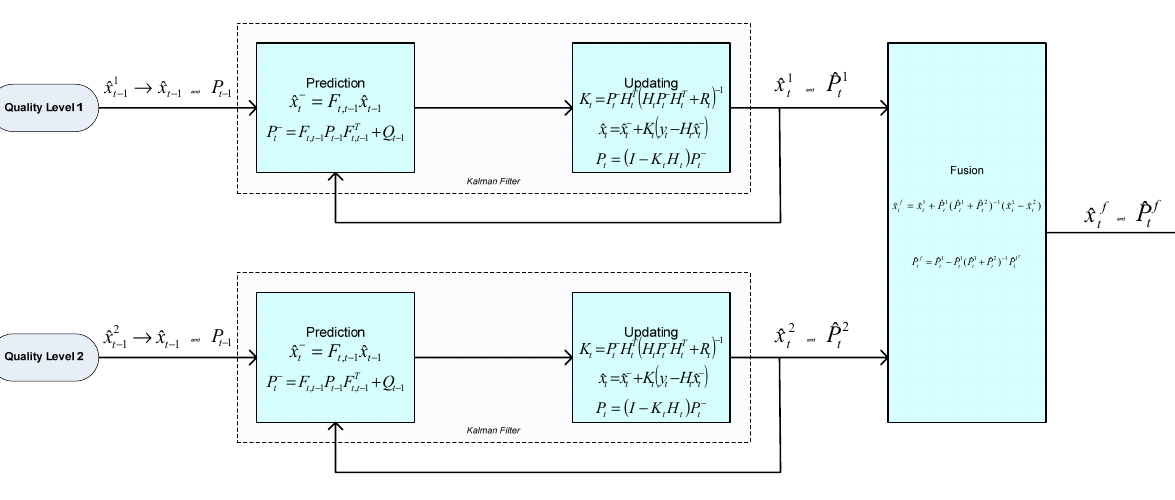
Figure 8. Detailed data fusion